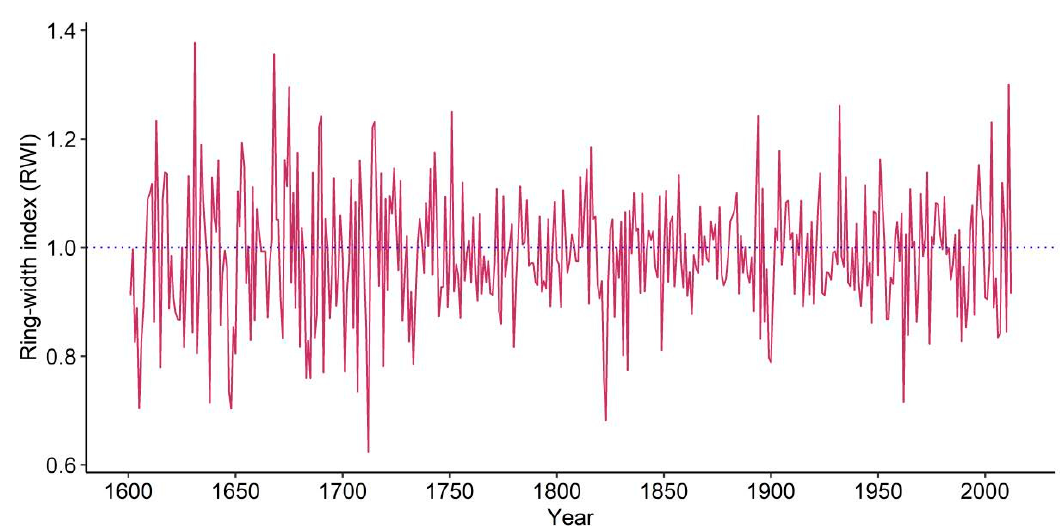
Figure 3. Residual site chronology of A. pindrow from high elevation limits of Hirpora Wildlife Sanctuary.